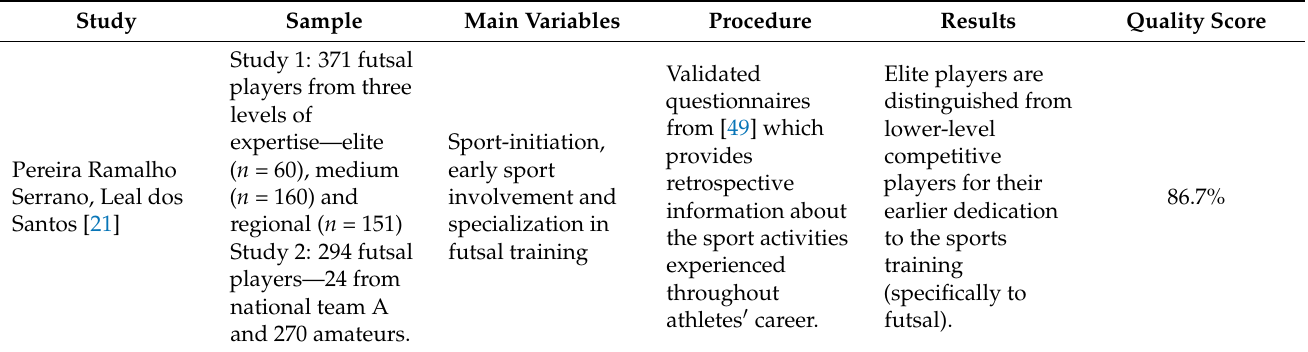
Table 3. Studies with predominantly specificity and volume of futsal-specific practice